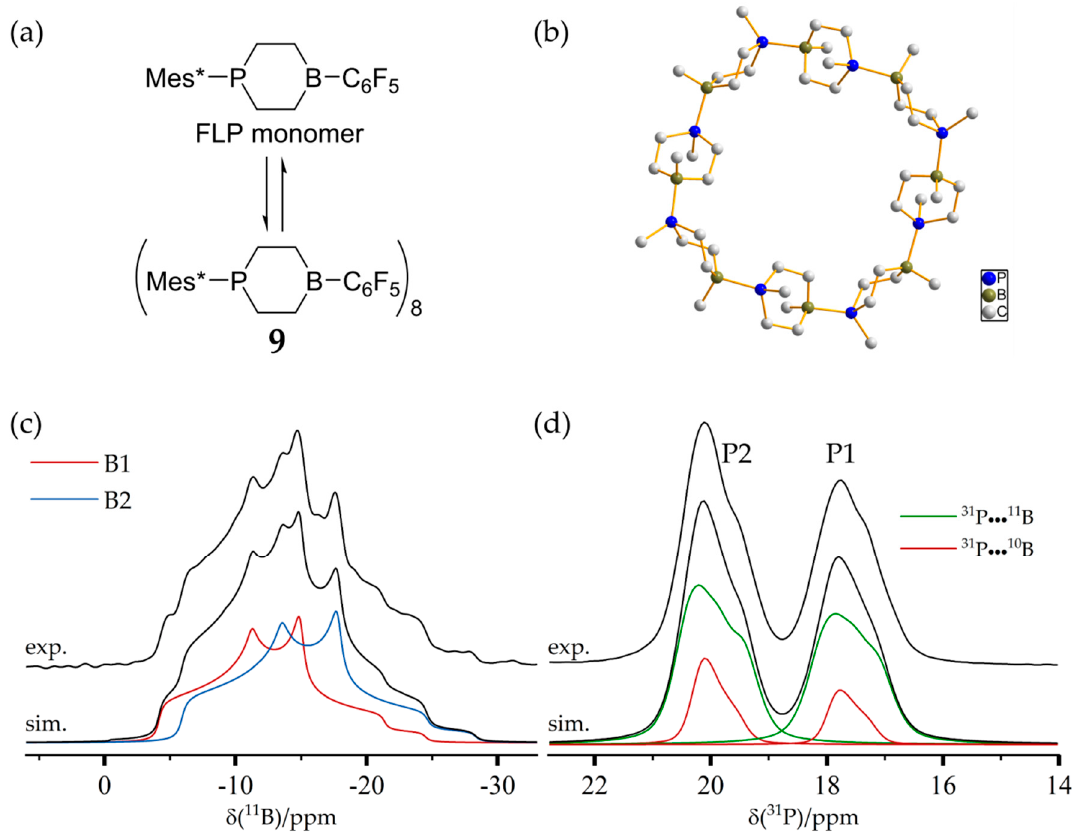
Figure 31. ( a ) Schematic representation of FLP monomer 6 and FLP-cyclooctamer 9 and ( b ) molecular structure of 9 , as well as the respective experimental and simulated ( c ) 11 B and ( d ) 31 P MAS NMR spectra of 9 .